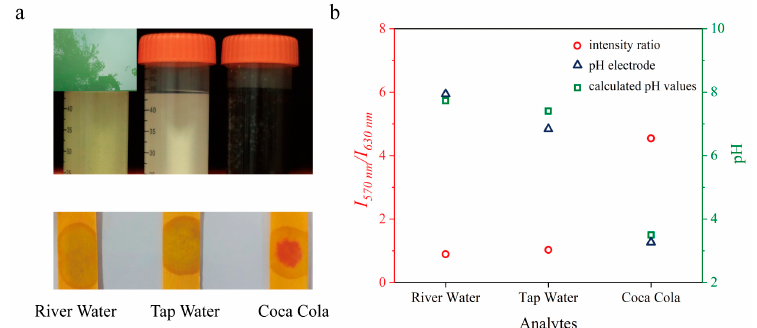
Figure 7. Determination of pH values in aqueous samples using the pH nanosensors. ( a ) Top: pictures of the tested samples, from left to right: river water, tap water, and Coca Cola. Bottom: pH determination using pH test stripes. ( b ) pH values determined using the nanosensors and pH elec- trode.